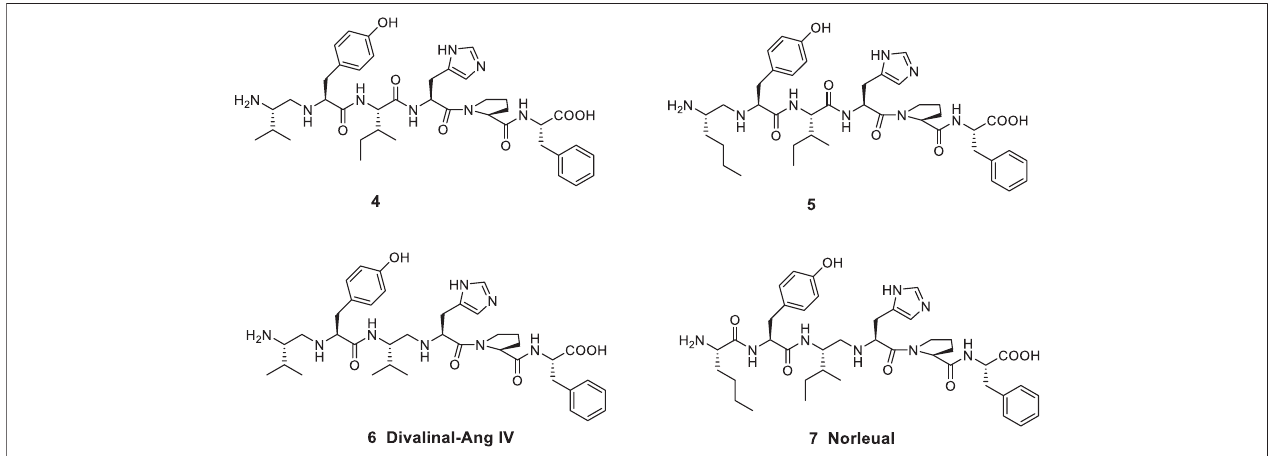
Figure 2 | Linear peptides with high af fi nity to the angiotensin IV (AT4) receptor and that are less prone to proteolytic degradation.